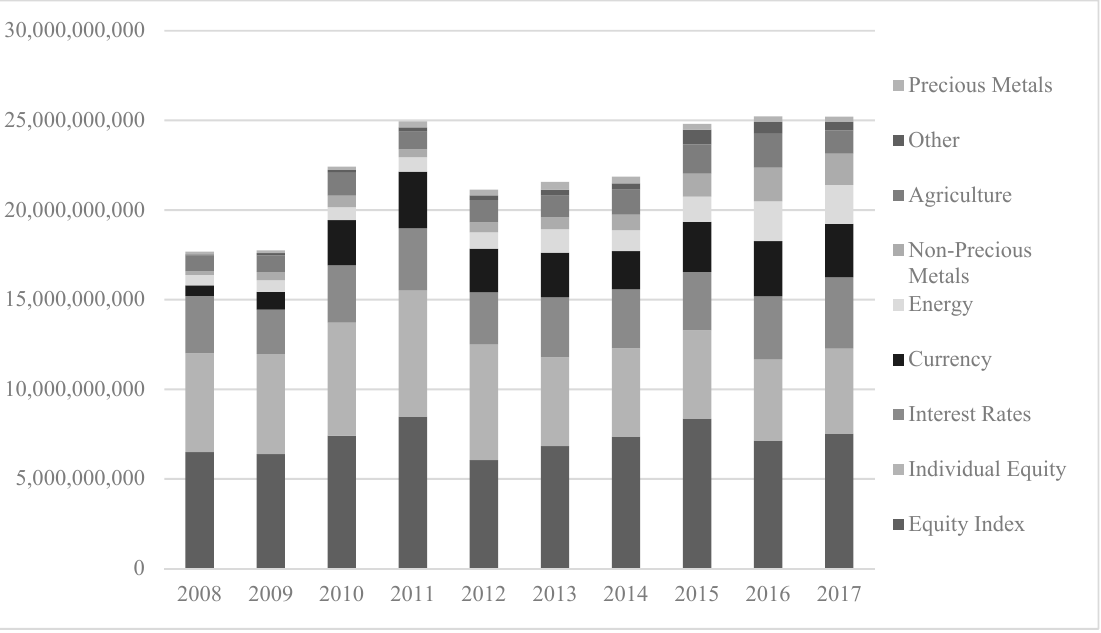
Figure 1. Annual volume of exchange-traded futures and options by category. Source: (Future Industry Association n.d.). Table 2. The daily average OTC turnover.